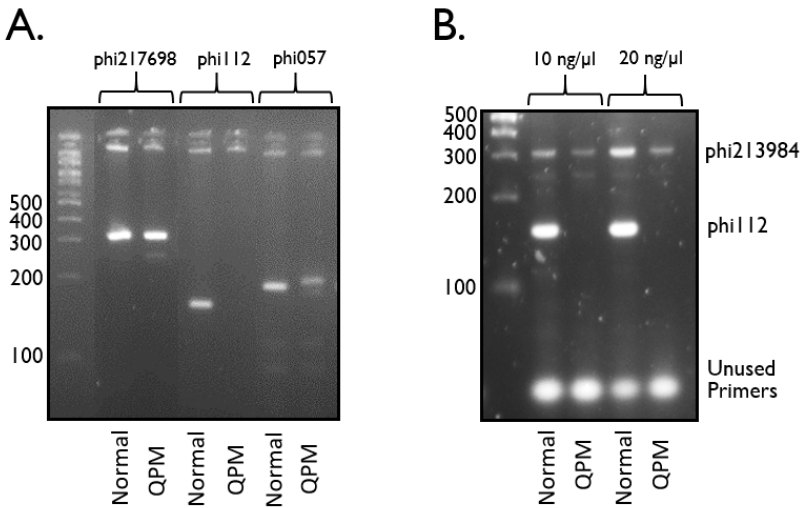
Figure 4. Standardization of primers and designing of multiplex PCR. ( A ). PCR using primers phi217698, phi112 and phi057. ( B ). Multiplex PCR using primers phi217698 and phi112. A total of 1 µL of two concentrations of genomic DNA, viz., 10 and 20 ng/µL, each of normal and QPM genomic DNA, were used in a 20 µL PCR for